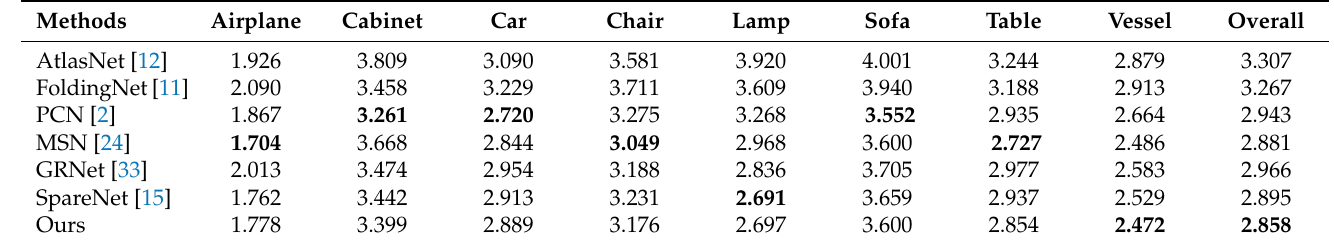
Table 5. Point completion results on PCN in EMD × 10 3 (lower is better).